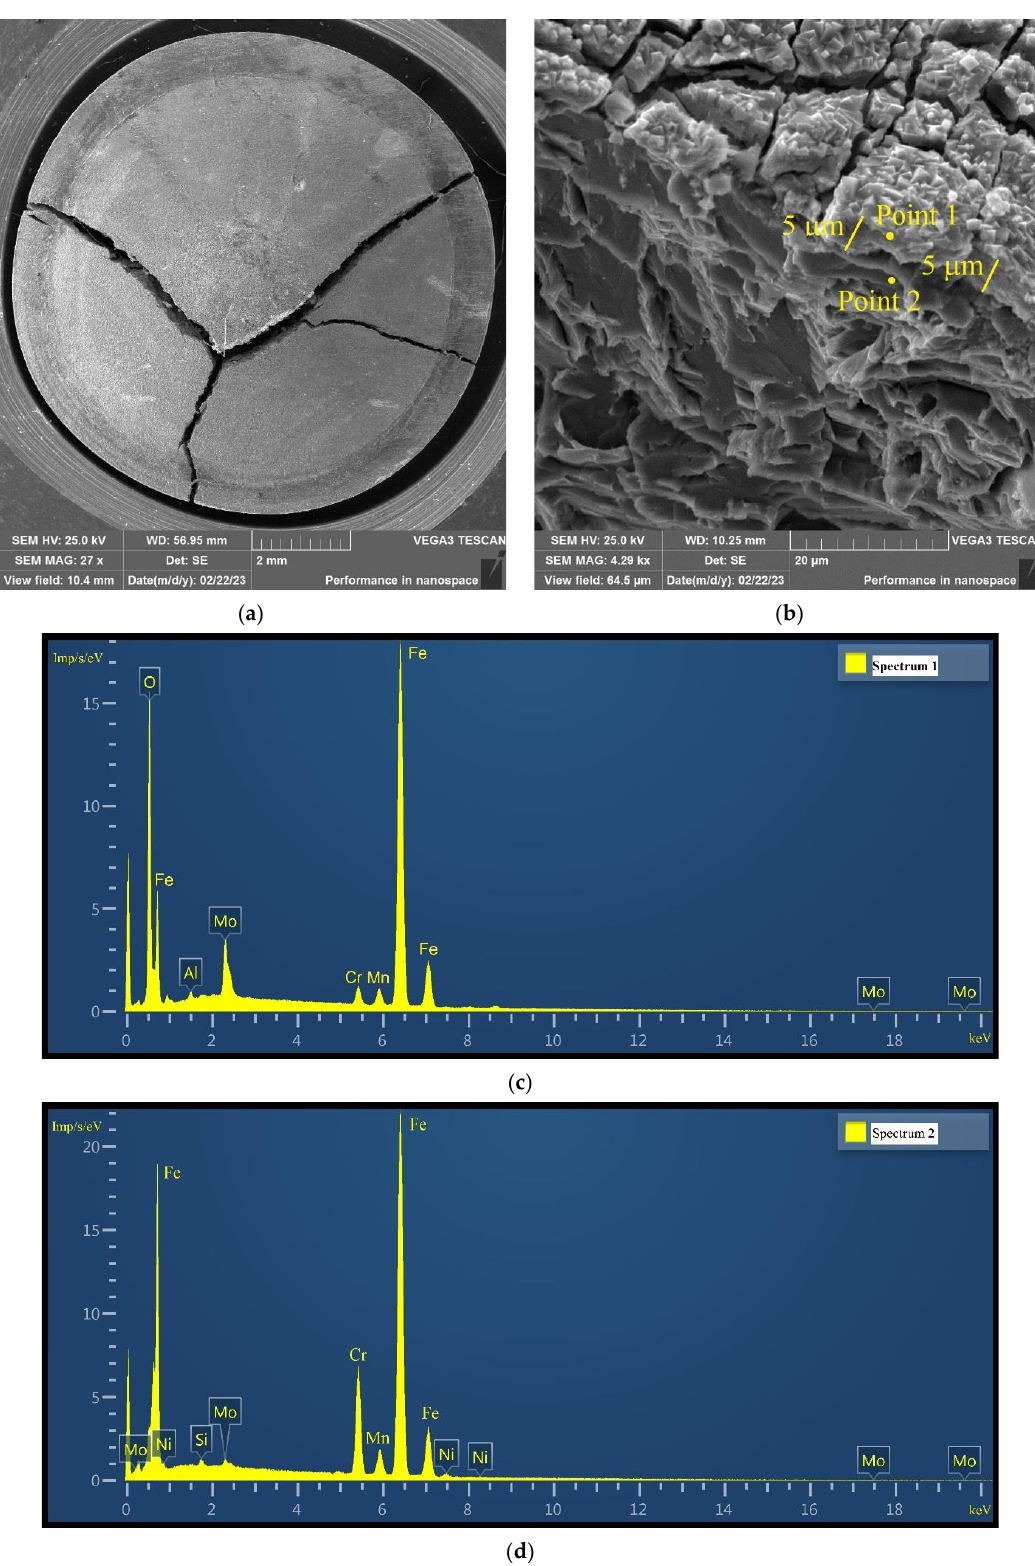
Figure 23. Surface of the disk specimen (T irr = 390 ◦ C) after autoclave SCC test with a load value of 801 N fractured at minus 140 ◦ C. An overall view of broken-disk specimen ( a ). Fractured surface of broken-disk specimen( b ). An oxide layer of ~5 µ m thick is observed. Under the oxide layer there is a microcleavage fracture of the metal (12Cr F/M steel) ( b ). EDS spectra for points 1 ( c ) and 2 ( d